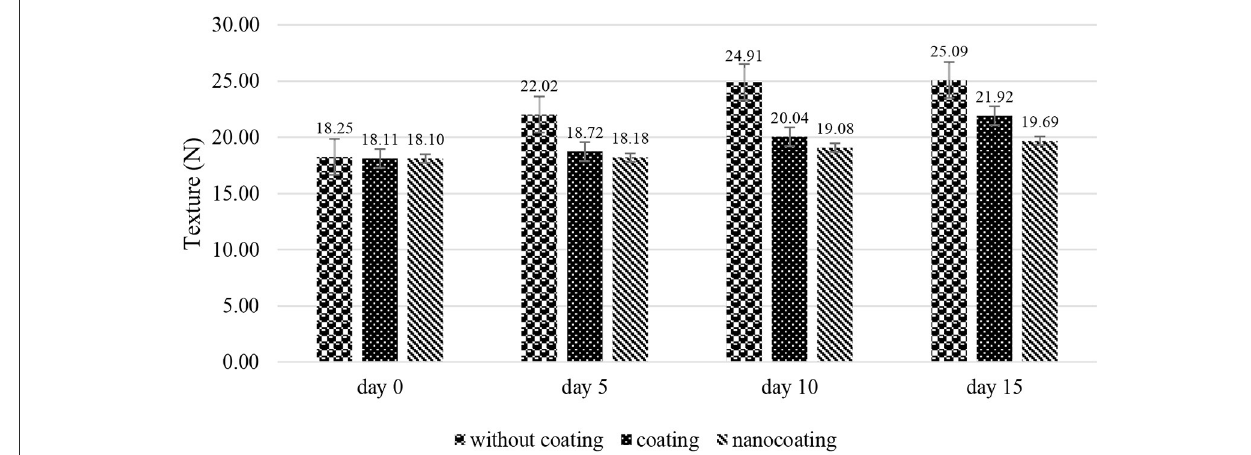
FIGURE3 Texture of Siamese orange.